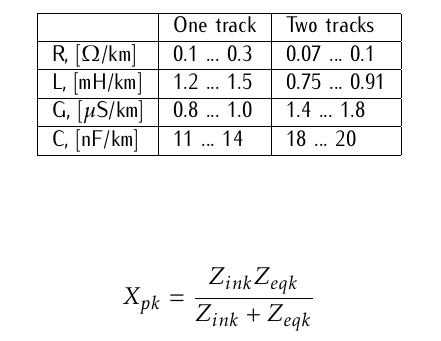
Table 2. Typical parameters values of railway networks.